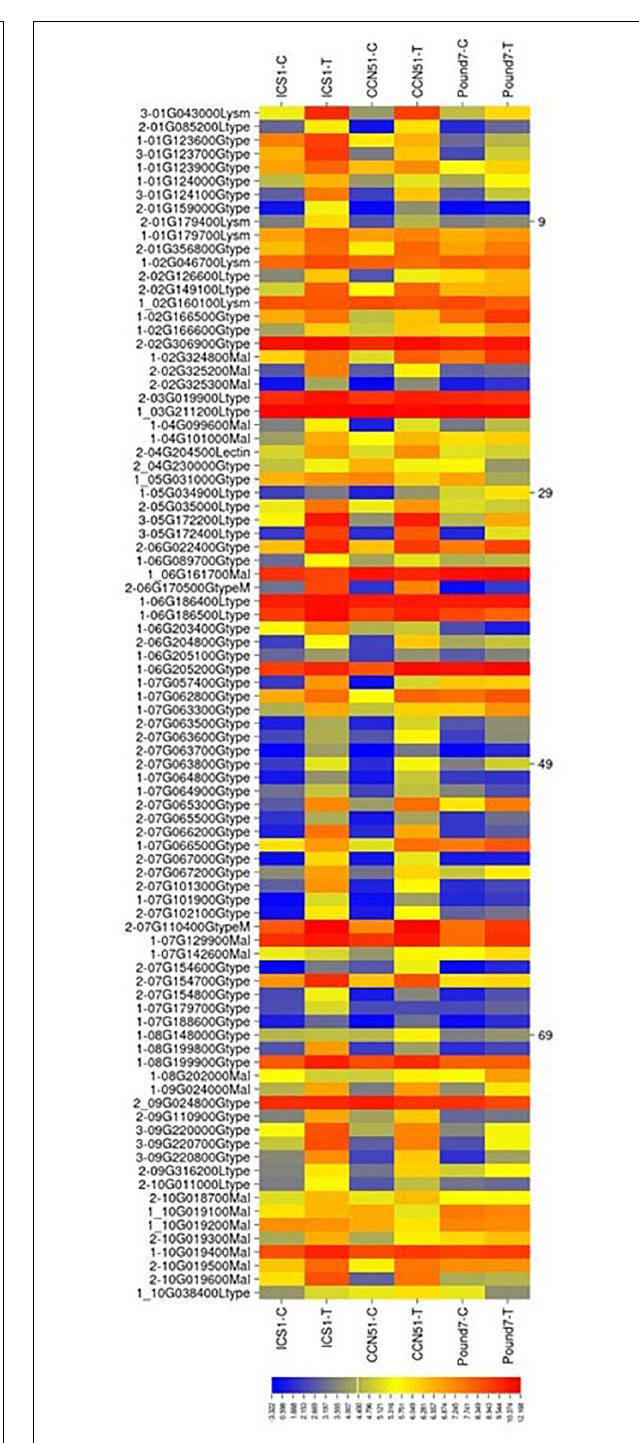
FIGURE 4 | A heat map displaying relative expression levels of cacao gene, putatively encoding lectin-related proteins in young red leaves of ICS1, CCN51, and Pound7 24 h after inoculation with 20- µ l drops of zoospores (0.6 × 10 5 zoospores/ml). Only genes showing differential expression in at least one genotype were included. Initial numbers indicate the number of genotypes with significant differential expression between treated and control